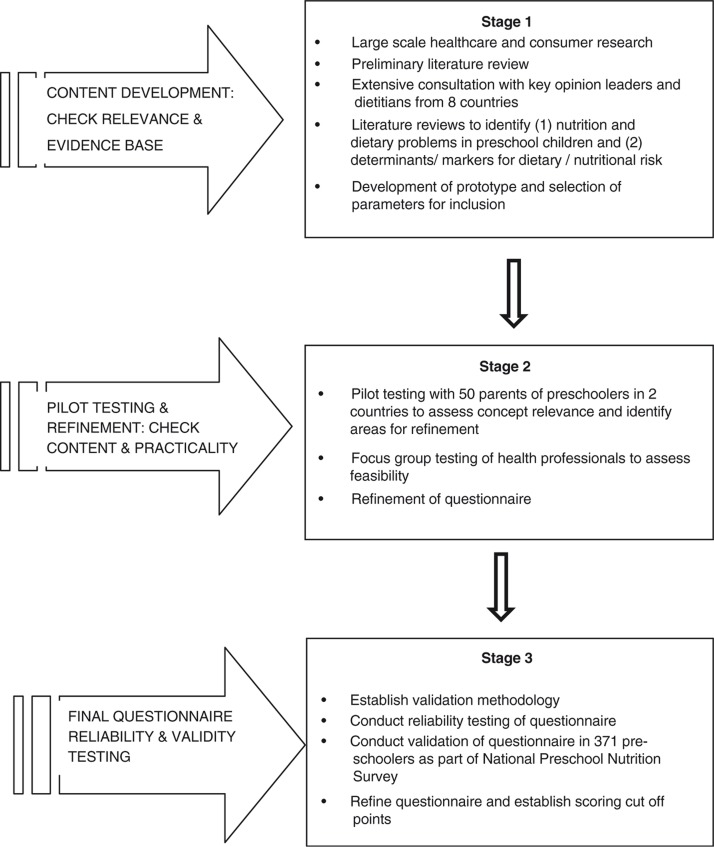
Overview of the development and validation process of NutricheQ.